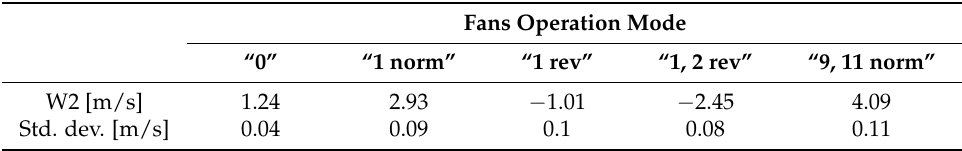
Table 4. Stable average air velocity for different configurations of fans.